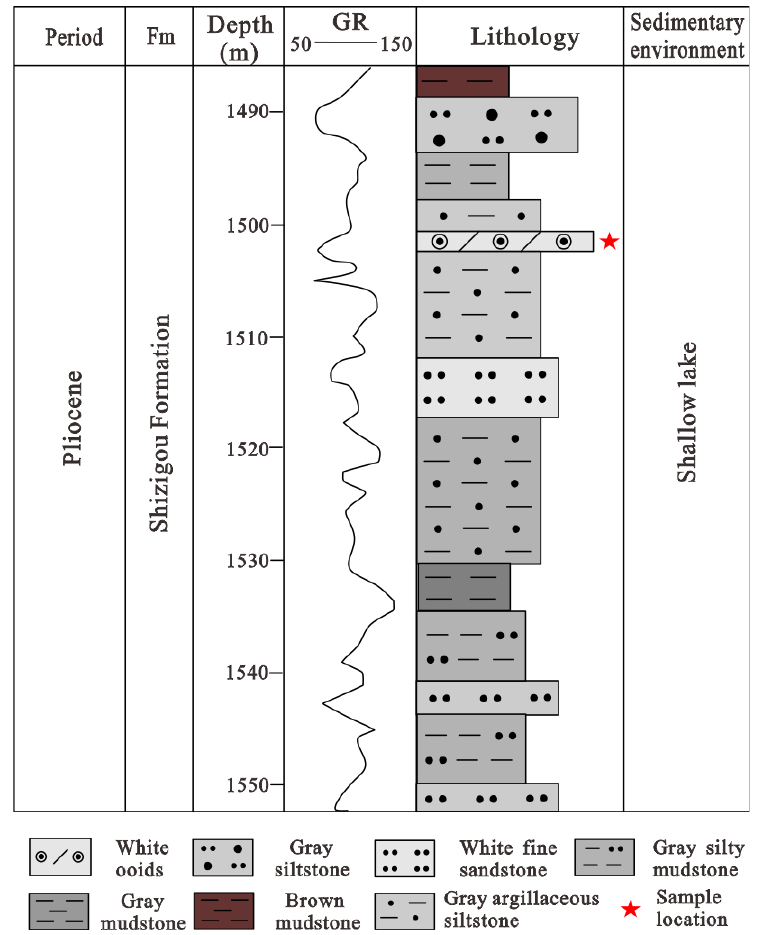
Figure 2. Sedimentological and petrophysical characteristics of the well Z1.